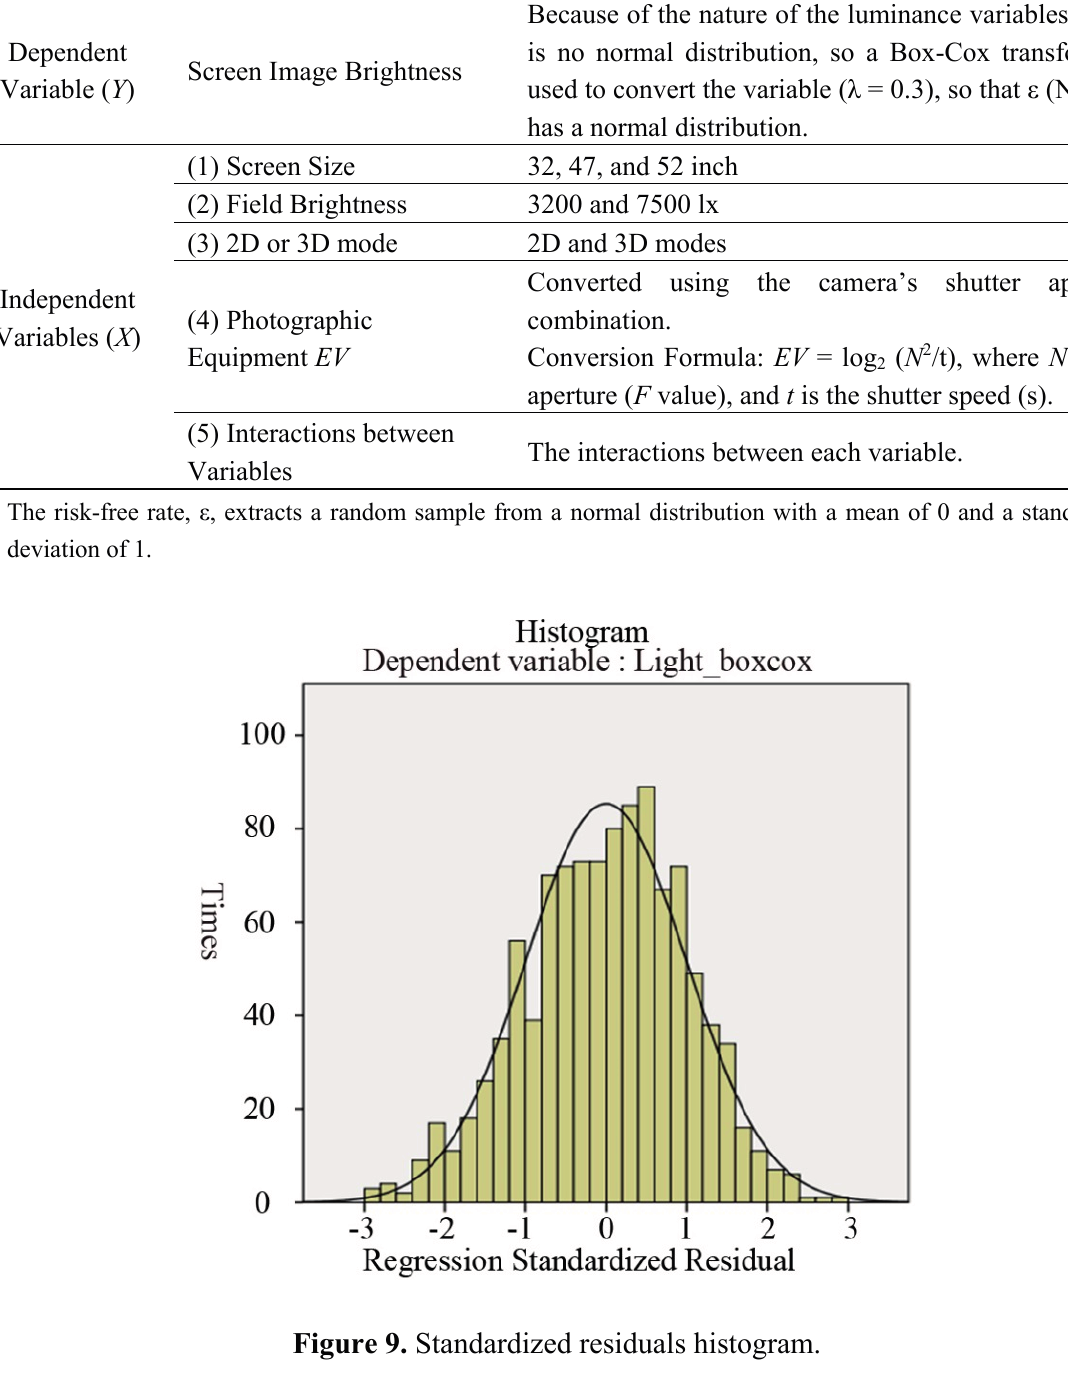
Figure 9. Standardized residuals